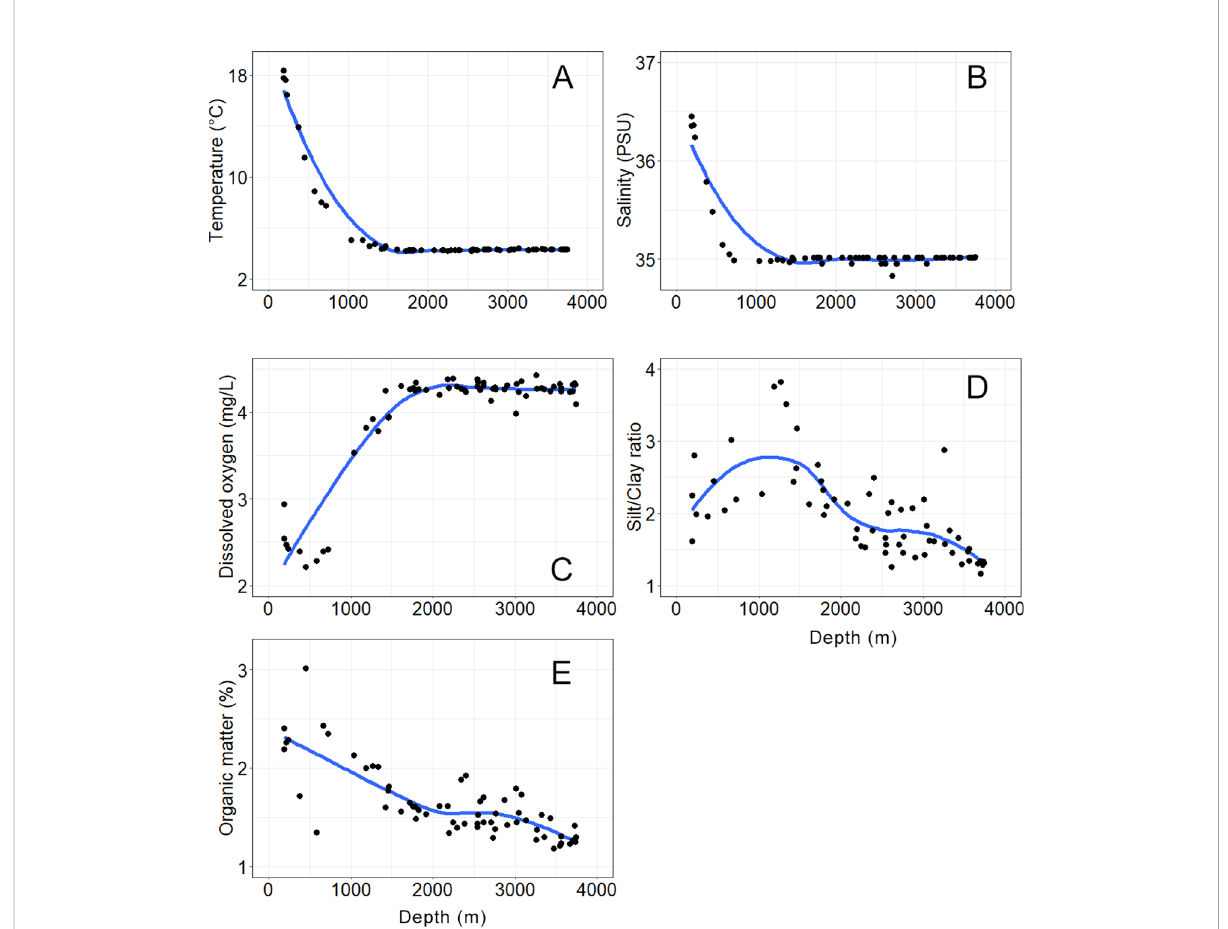
FIGURE 2 Abiotic variables in water column and sediments along a water depth gradient in 63 sites in the Southwestern Gulf of Mexico. (A) Temperature. (B) Salinity. (C) Dissolved oxygen. (D) Silt/clay ratio. (E) Organic matter content. Points represent averages over the four cruises. The best fi t curves in blue were calculated by LOESS